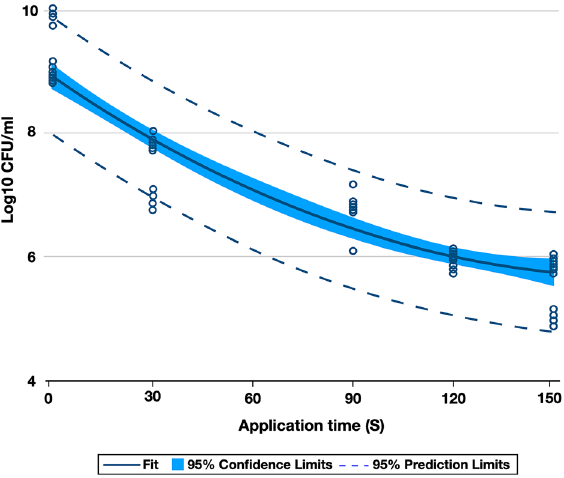
Figure 1. Polynomial regression of the CFU of the S. mutans biofilm treated with NTAP in different times